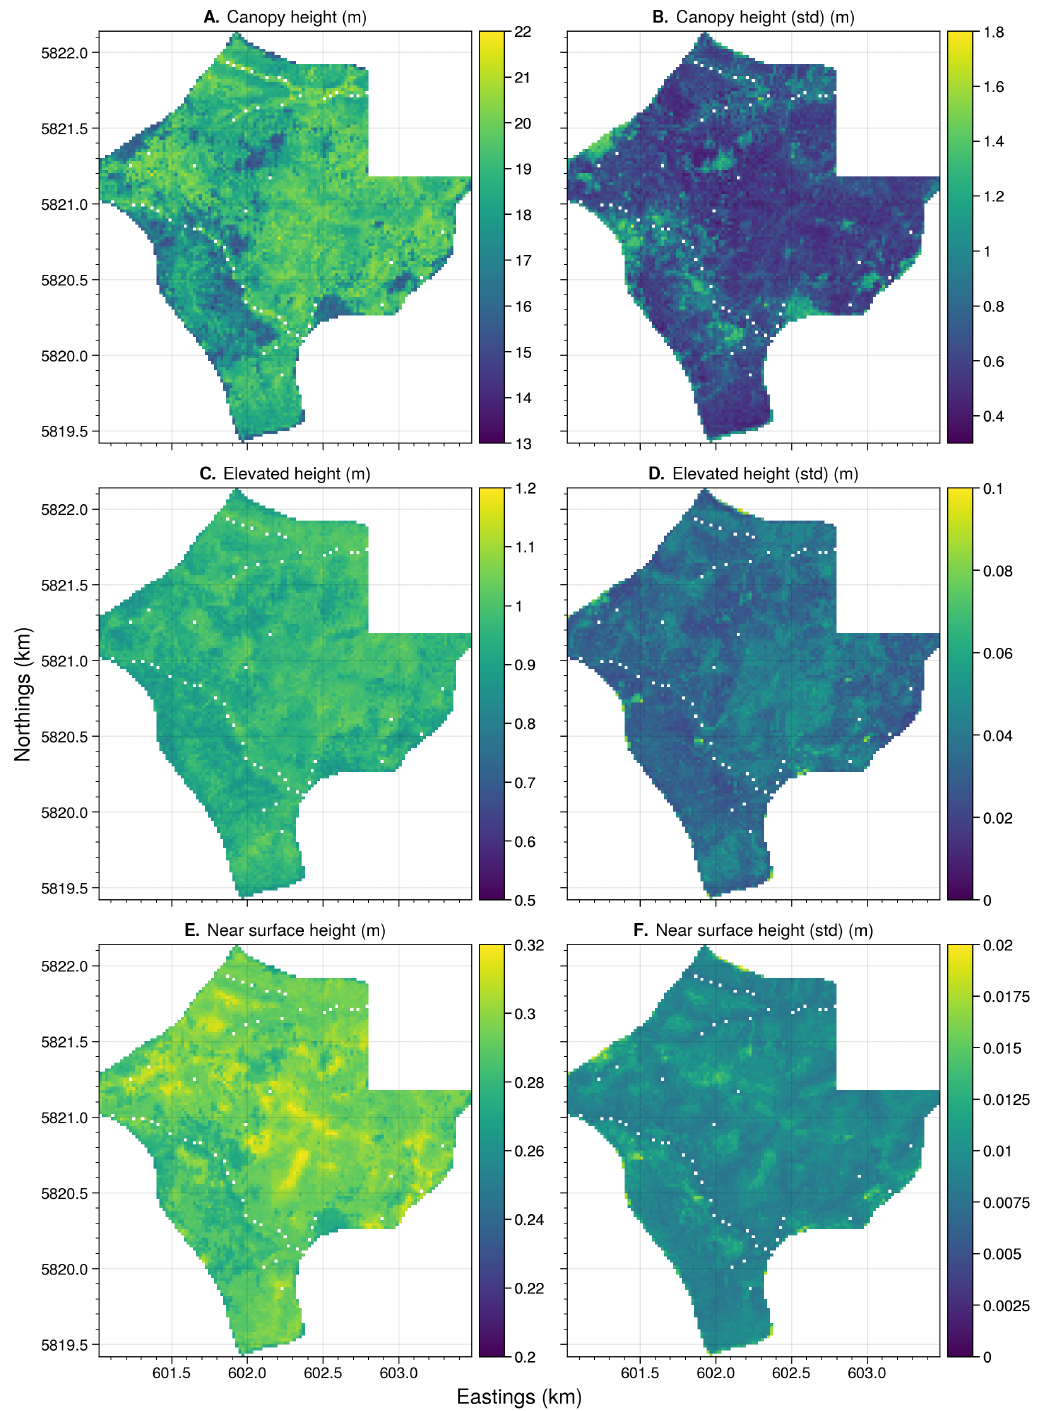
Figure A18. The mean and standard deviation predictions at landscape level for canopy ( A , B ), elevated ( C , D ), and near-surface ( E , F ) fuel height using TLS observations at